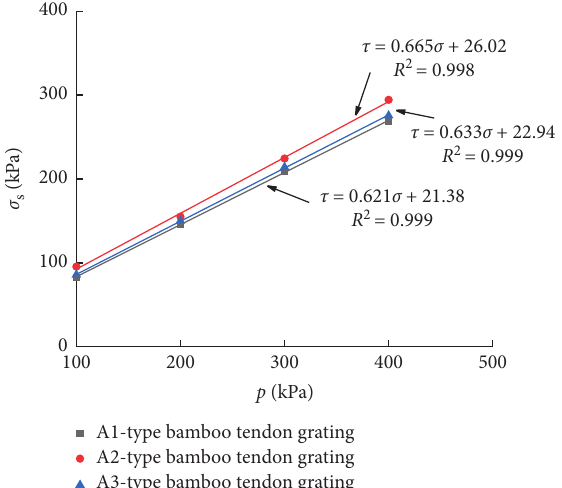
Figure 18: Relationship between shear strength and normal stress levels of reinforced bamboo tendon grating with different spacings.